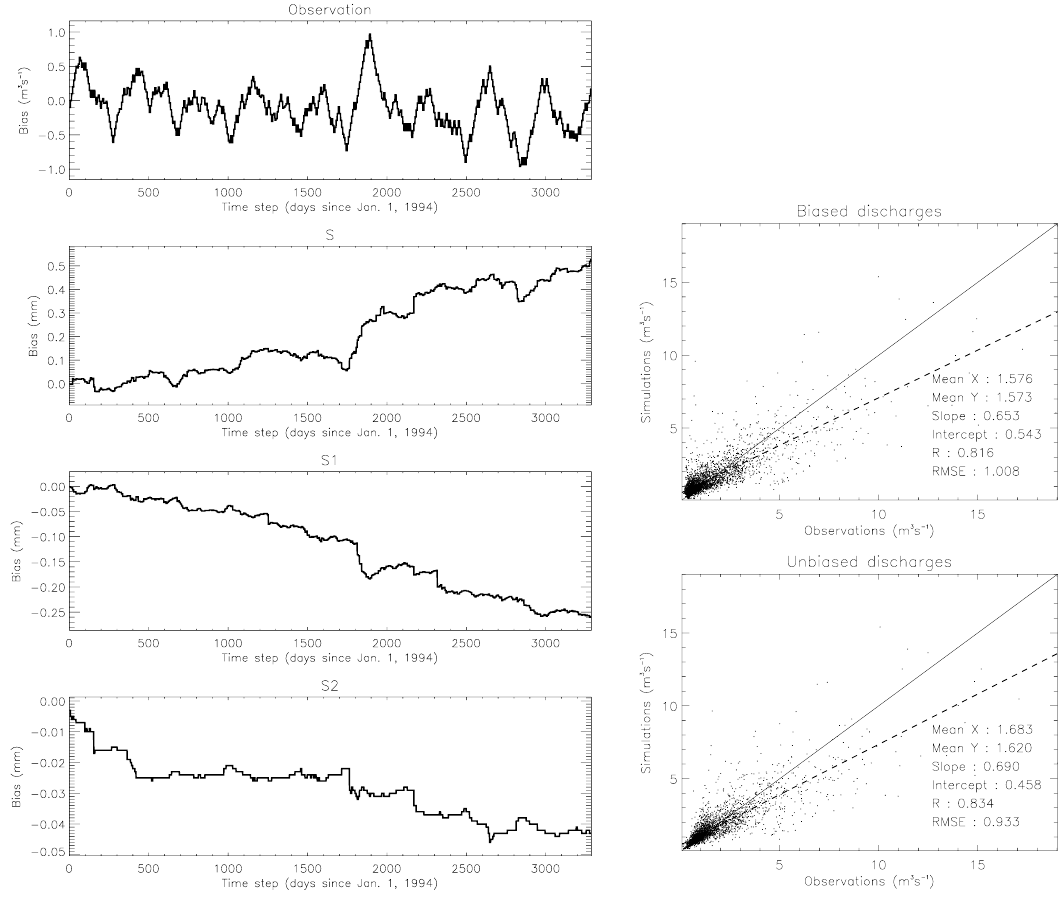
Fig. 13. Results of the assimilation of in situ observed discharge rates. Left panels: the bias estimates. The top plot shows the results for the observation bias. The following three plots show the bias in S , S 1 and S 2 . Right panels: the discharges.